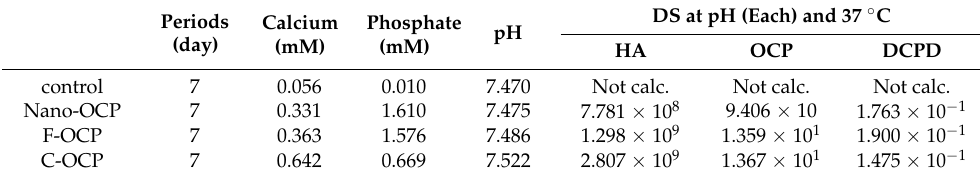
Table 1. Degree of supersaturation (DS) of Tris-HCl buffer (pH = 7.4) incubated with OCPs. Periods (day)